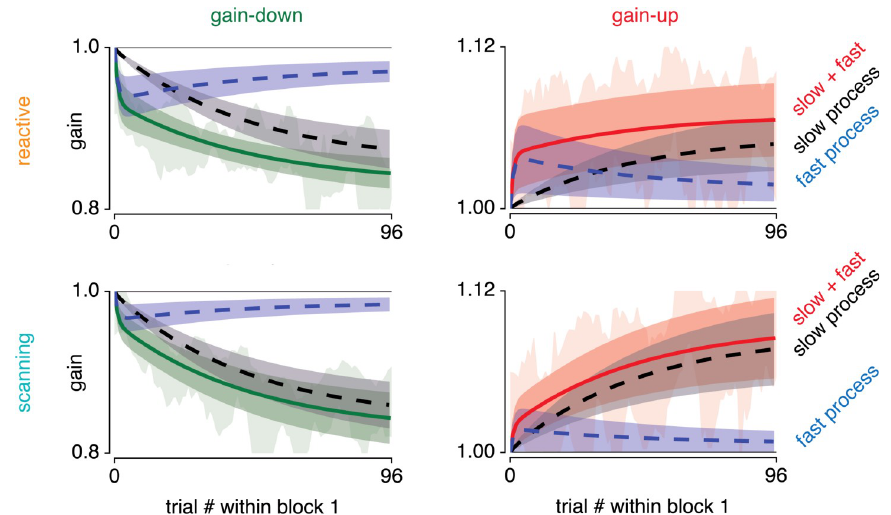
Fig 5. Dual-rate model fits to gain-up and gain-down adapted reactive and scanning saccades. Fitted fast (blue) and slow (black) processes to overall adaptation (green when gain-down and red when gain-up) to data from the second block. Shaded areas around model fits represent the 95% CI over participants. Underlying shaded data area indicates 95% CI over participants of moving average over six trials (as in Fig 3).